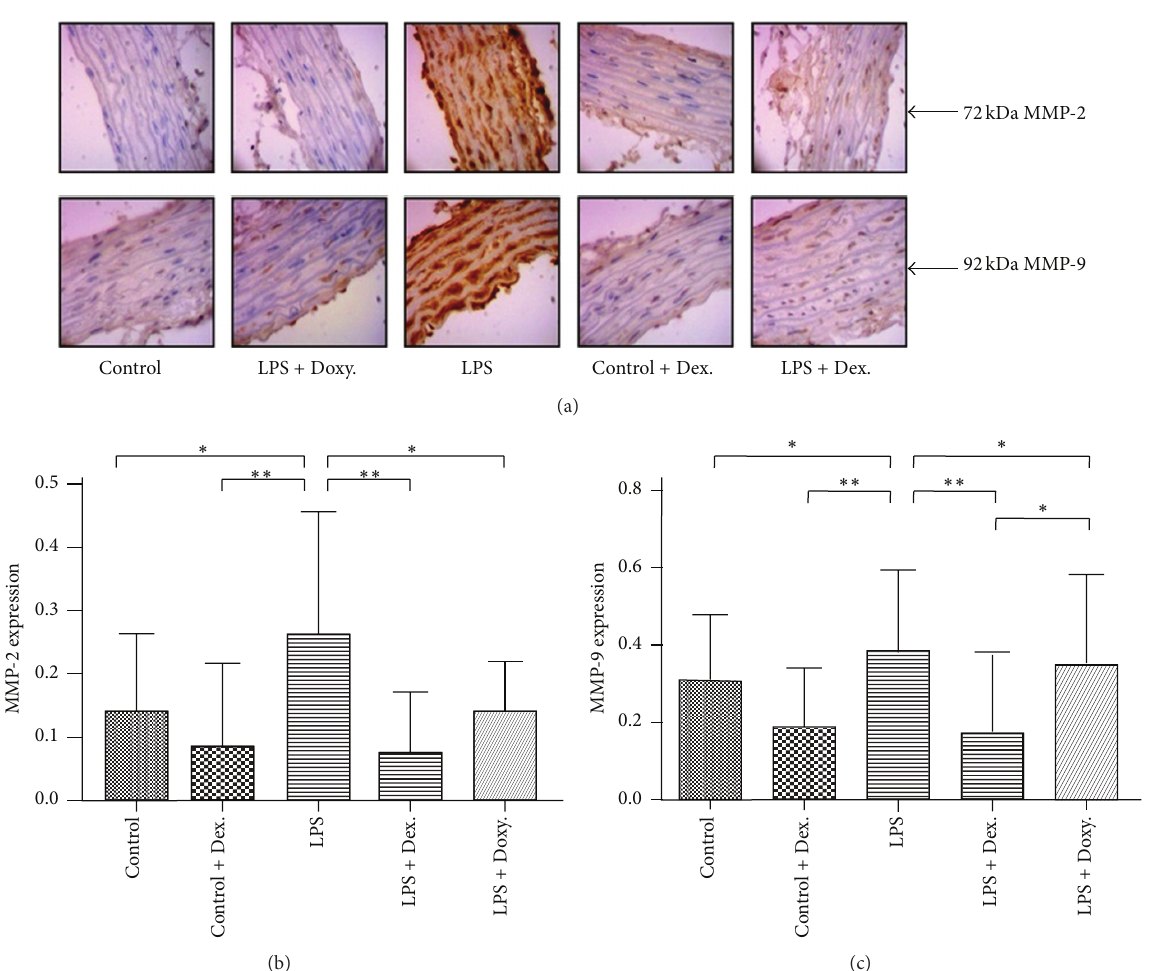
Figure 1: Immunohistochemistry of MMP-2 or MMP-9 expression. (a) As described in the method, expression of MMP-2 (72-kDa) and MMP-9 (92-kDa) in cross sections of thoracic aorta from each group was determined by immunohistochemistry. Data presented is one representative of 8 replicates in each group. (b and c) Average of 8 biological replicated samples from each group (mean ± SD). ∗ 𝑝 < 0.05 ; ∗∗ 𝑝 < 0.001